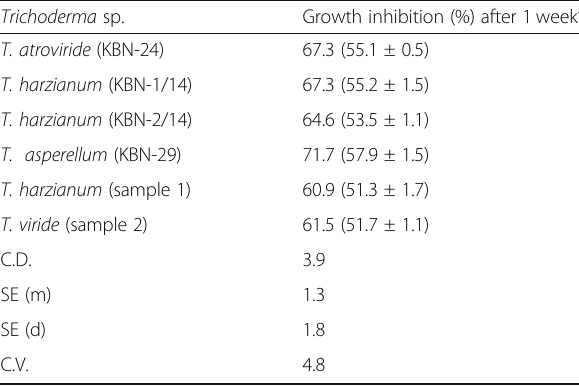
Table 1 In vitro bioefficacy of Trichoderma spp. against Fusarium solani Trichoderma